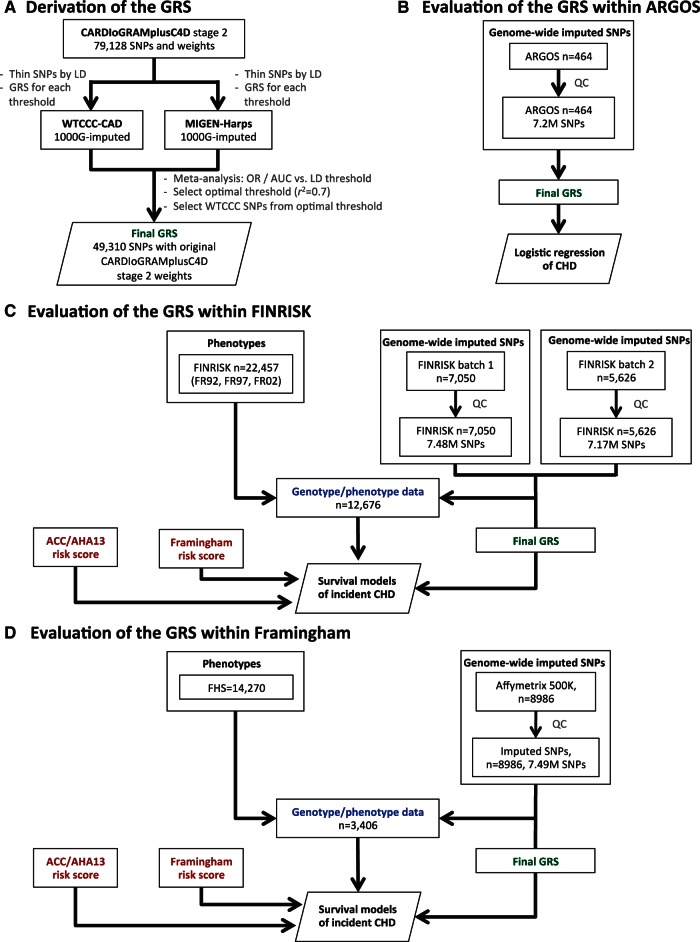
Study workflow. (A) The
procedure for deriving the GRS of incident CHD. The analysis workflow
for evaluating the GRS within (B) ARGOS,
(C) FINRISK, and (D)
FHS.